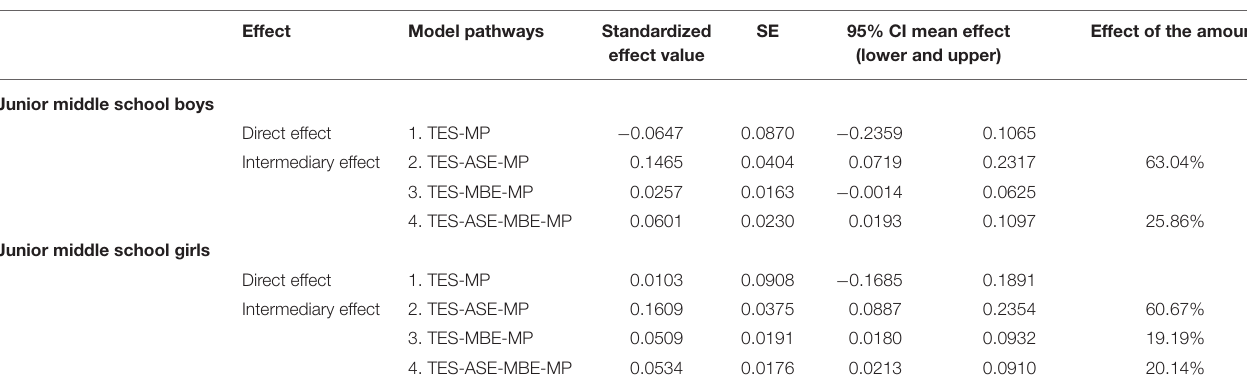
TABLE 4 | Bootstrap analyses of the significance of